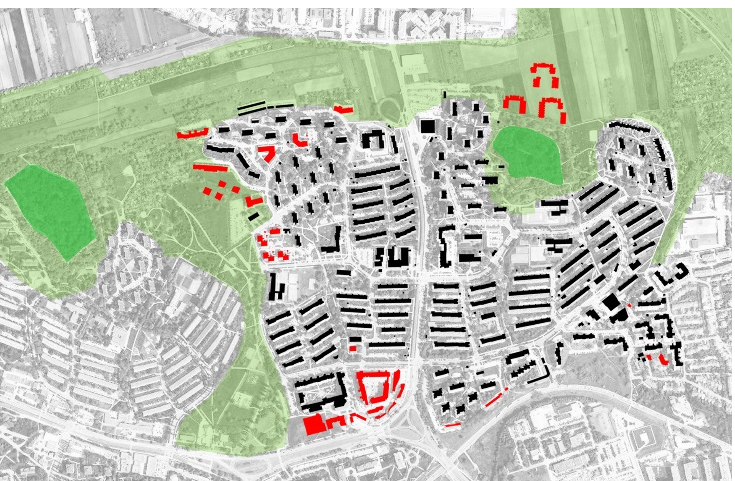
Figure 10. Densifications of housing estates in Mistrzejowice in the context of green areas of the fortress constituting their buffer zone and other green areas enveloping the housing estates (green). Color legend: black buildings—developments from before 1995 (mostly within the scheme of the construction of the Bohaterów Wrze ś nia i Piastów housing estates); red—densification—developments from after 1995. Based on an ortophotomap (www.maps.google.com, accessed on 5 December 2021).